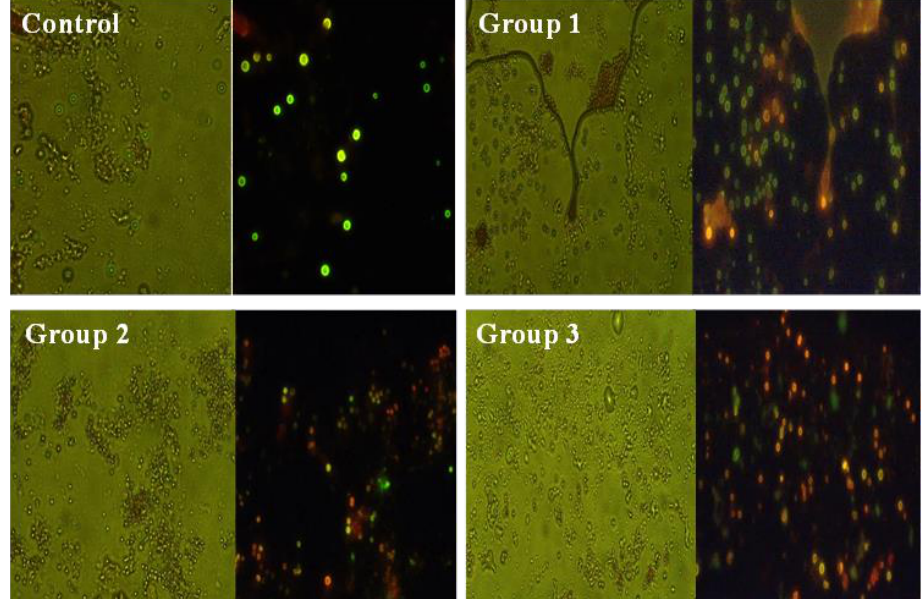
Figure 6. AO/EtBr fluorescent staining of Oreochromis mossambicus (liver tissues) treated with 14 days of polypropylene microplastics treated groups [100 mg/kg (Group 1), 500 mg/kg (Group 2), 1000 mg/kg (Group 3)] and control group showing healthy cells — green colour; unhealthy 1000 mg/kg (Group 3)] and control group showing healthy cells—green colour; unhealthy cells— cells — orange and red colour. orange and red